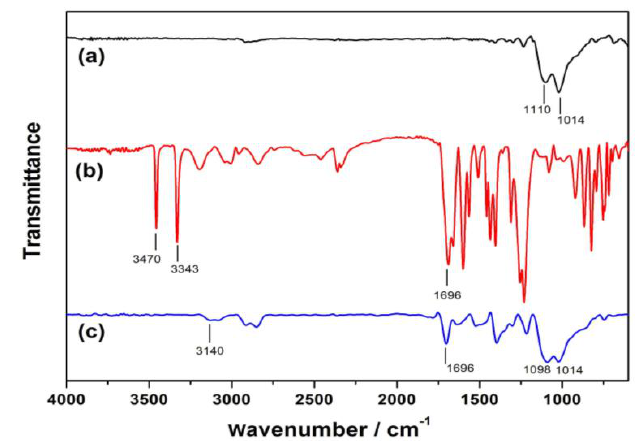
Figure 4. Fourier transform infrared spectroscopy (FTIR) spectra of Fe 3 O 4 /Au ( a ), 5-aminoorotic acid (AOA) ( b ), and Fe 3 O 4 /Au–AOA ( c ).